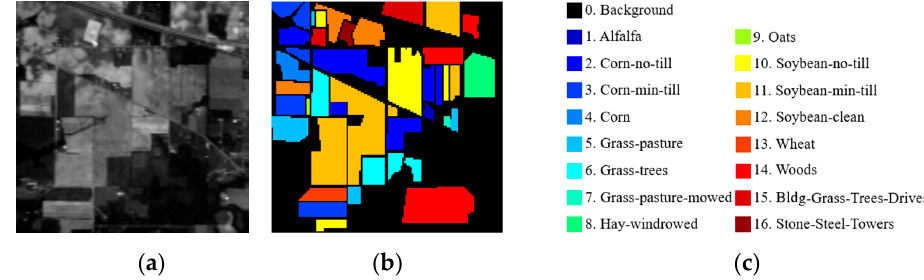
Figure 5. Purdue image scene. ( a ) Band 20th; ( b ) Ground truth map; ( c ) Ground truth class labels.